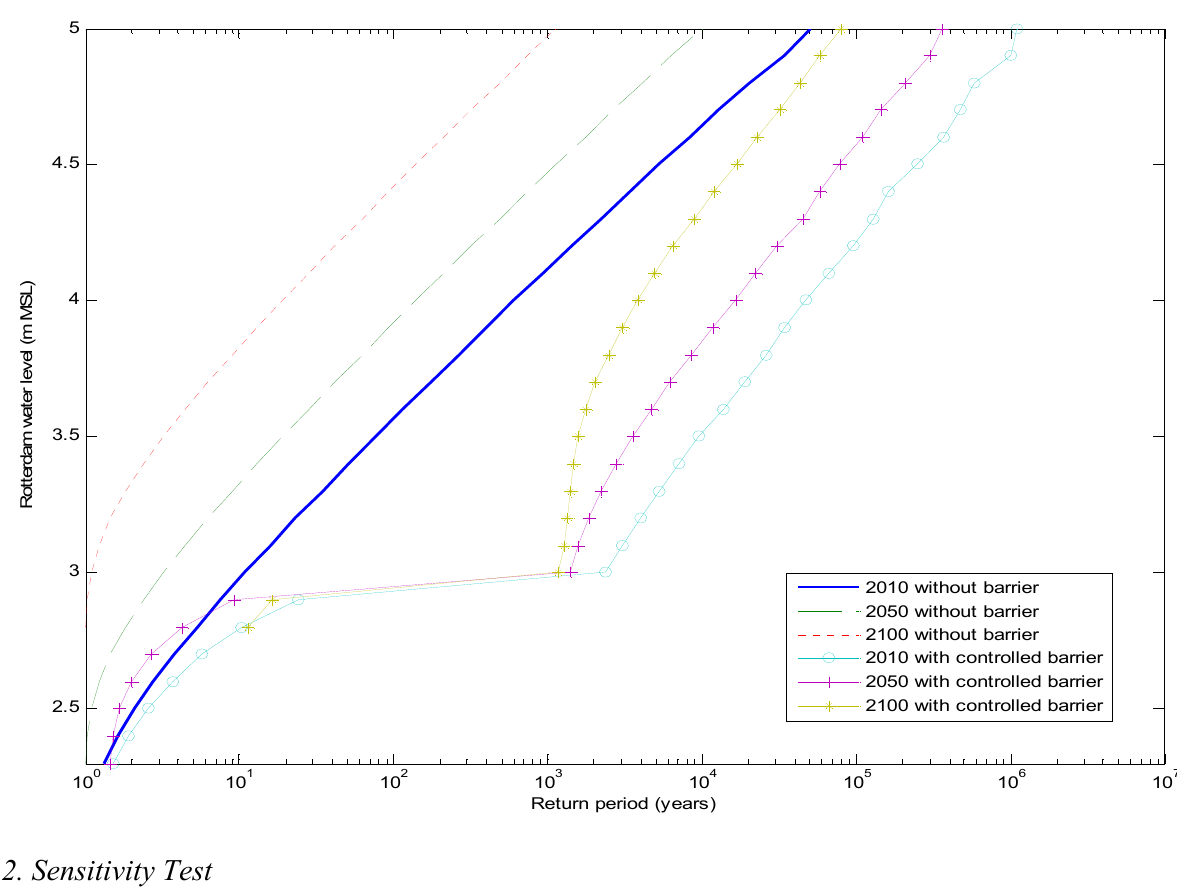
Figure 13. Return period at different